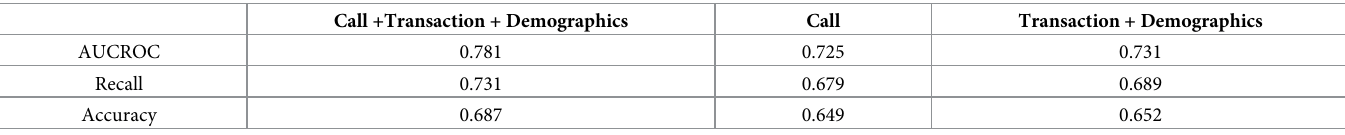
Table 7. Testing results—Predicting financial trouble as a function of different feature